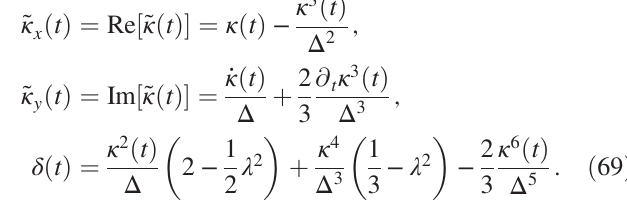
ffiffiffi p 2 . Without